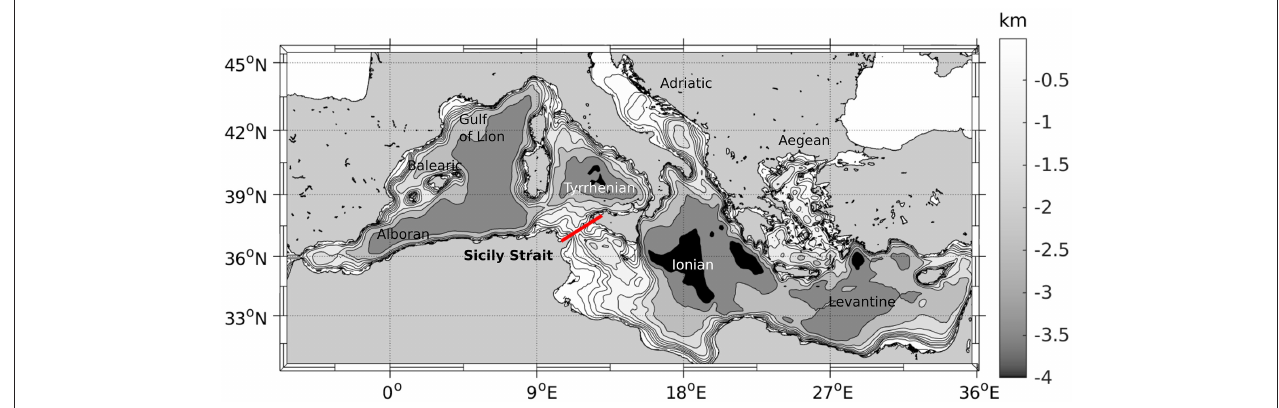
FIGURE 1 | Model’s bathymetry of the Mediterranean Sea with the names of the main basins. The Sicily Strait transect used in Figure 4 is indicated by the bold red